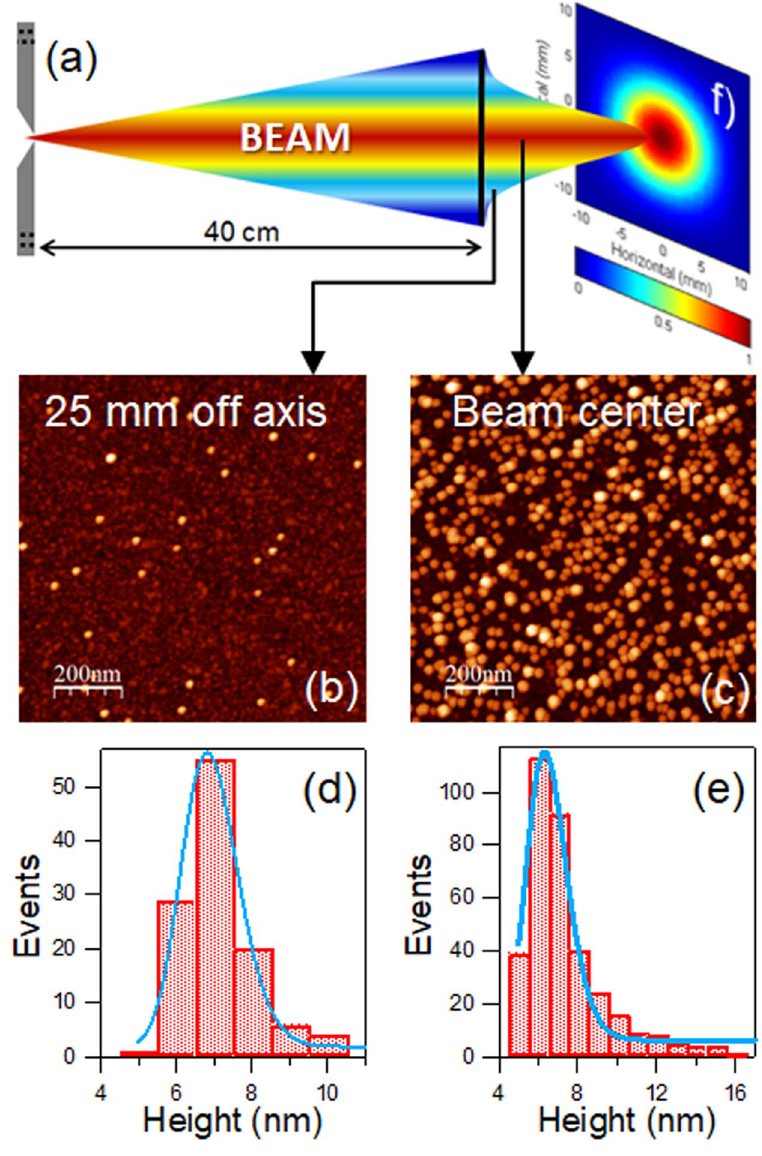
Figure 4. ( a ) Illustration of the beam divergence at the exit of the MICS with the Gaussian profile measured with QCM-1. AFM images of nanoparticles collected ( b ) at 25 mm off axis and ( c ) at the beam center. Log- normal distribution of the height on the nanoparticles collected ( d ) at 25 mm off axis, and ( e ) at the beam center. ( f ) Beam shape derived from the optical absorption measured in the mid-IR region of nanoparticles deposited on a glass slide at 740 mm from the MICS